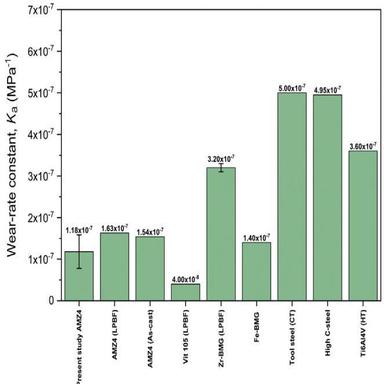
Comparison of wear-rate constants among our AMZ4 processed by LPBF; AMZ4 processed by LPBF and as-cast; Vit 105 (Zr52.5Cu17.9Ni14.6Al10Ti5) processed by LPBF; a Zr-based BMG (Zr60.14Cu22.31Fe4.85Al9.7Ag3) processed by LPBF; an Fe-based BMG used as coating and produced by laser cladding,; a cryogenically treated tool steel produced conventionally; a high‑carbon steel produced conventionally; and heat-treated Ti6A